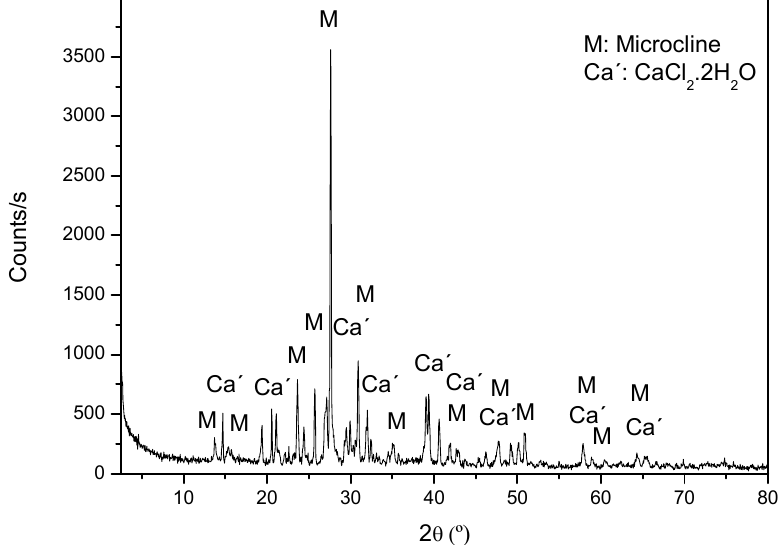
Figure 4. XRD pattern of the chlorination residue of the Mi sample at 600 °C for 15 min without filtration and washing treatments.